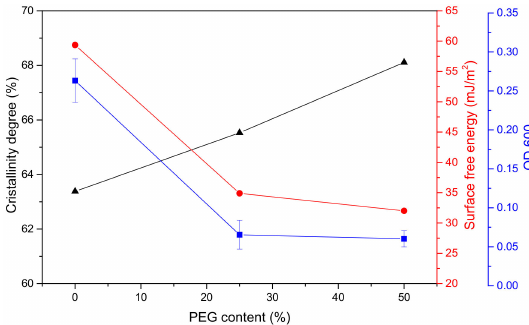
Figure 13. Bacteria attached (OD600) to the coatings, crystallinity and surface free energy with PEG content.